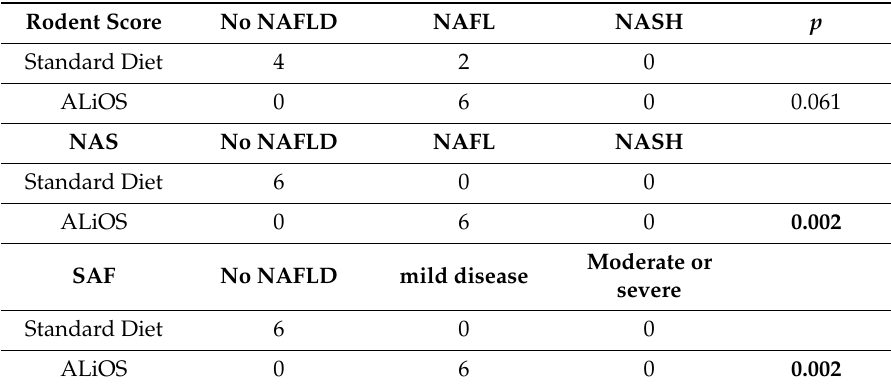
Table 1. Histological scoring for fatty liver disease. Wildtype mice were fed standard diet or ALiOS diet for 24 weeks. Liver sections were categorized by a blinded pathologist according to the indicated scoring systems. p value for the Fisher test is given.